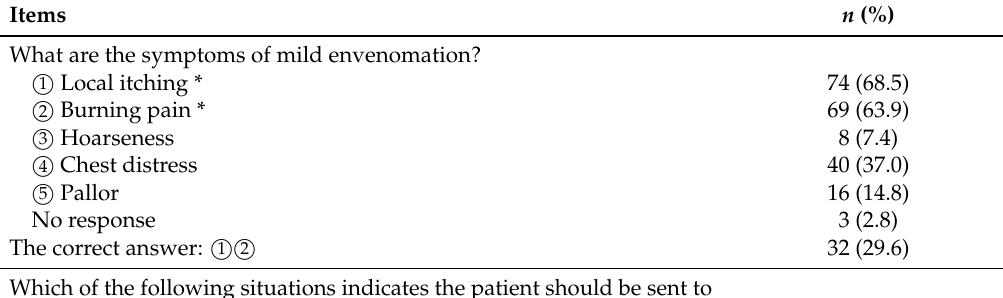
Table 3. Knowledge about the manifestation of envenomation ( n = 108).